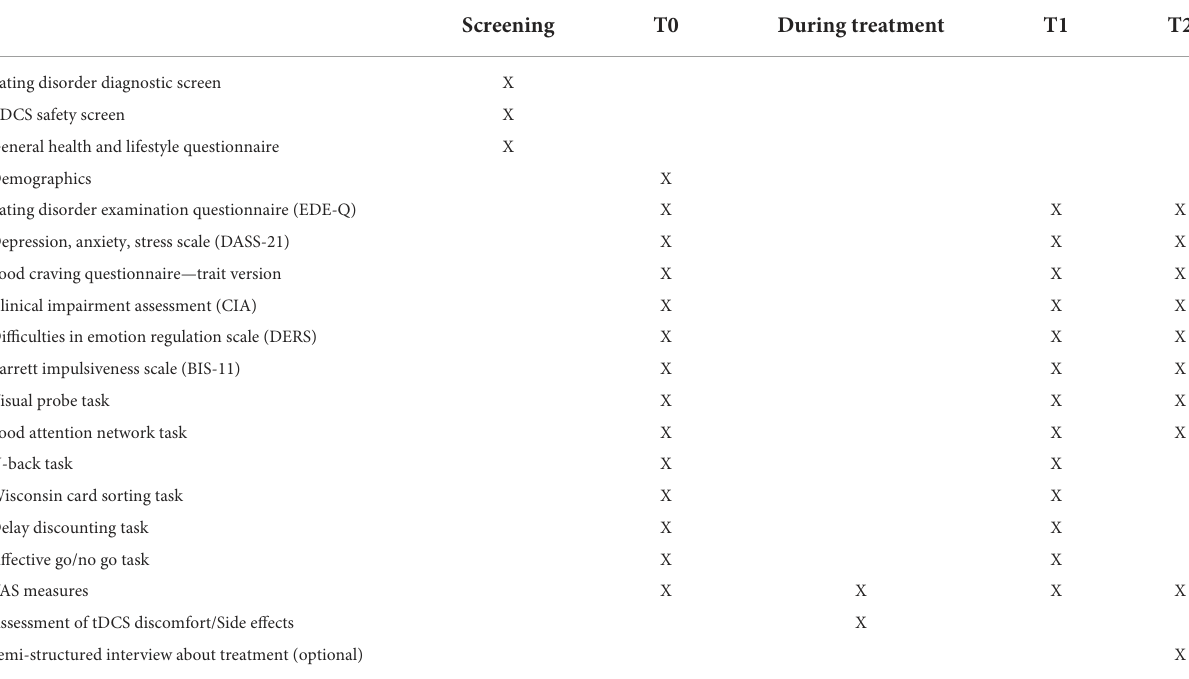
TABLE 1 Summary of outcome assessment by visit.